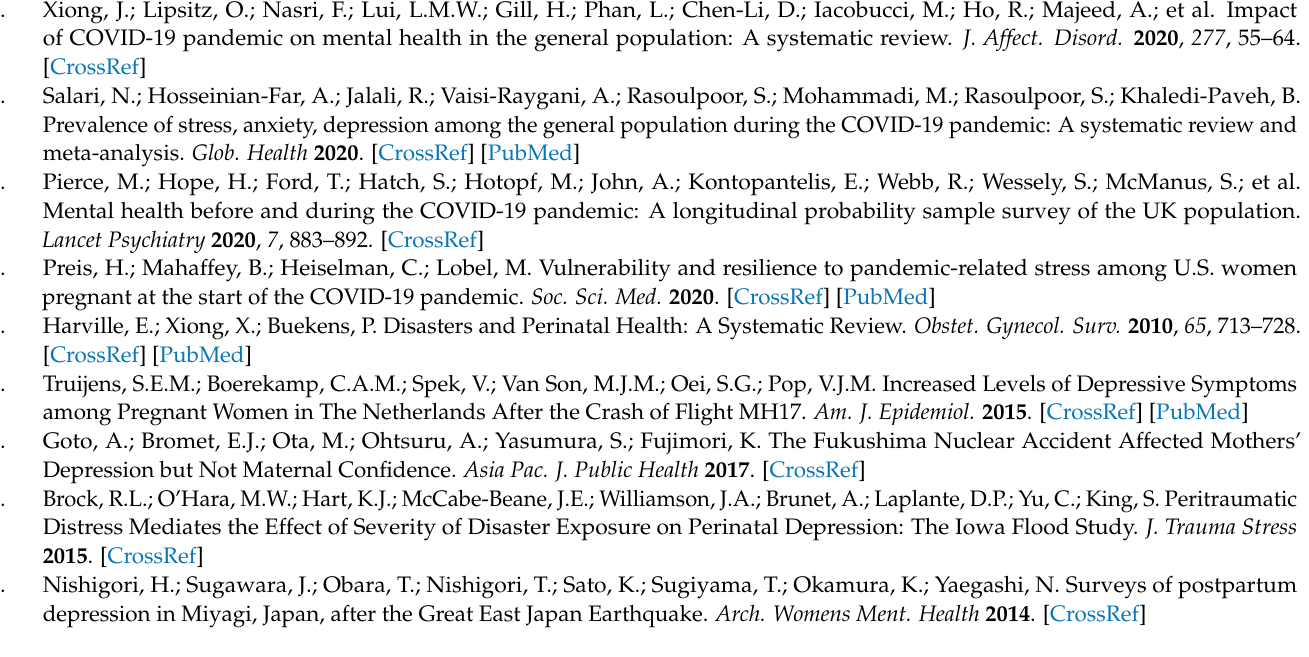
Table S3: Propensity-score matching using a combination of age and education—Stata output, Table S4: Propensity-score matching using a combination of age, education, income and employment status—Stata output. Figure S1: COVID-19 Related Thoughts in Pregnancy (Preis, Mahaffey, and Lobel, 2020), Figure S2: Propensity-score matching using a combination of age and